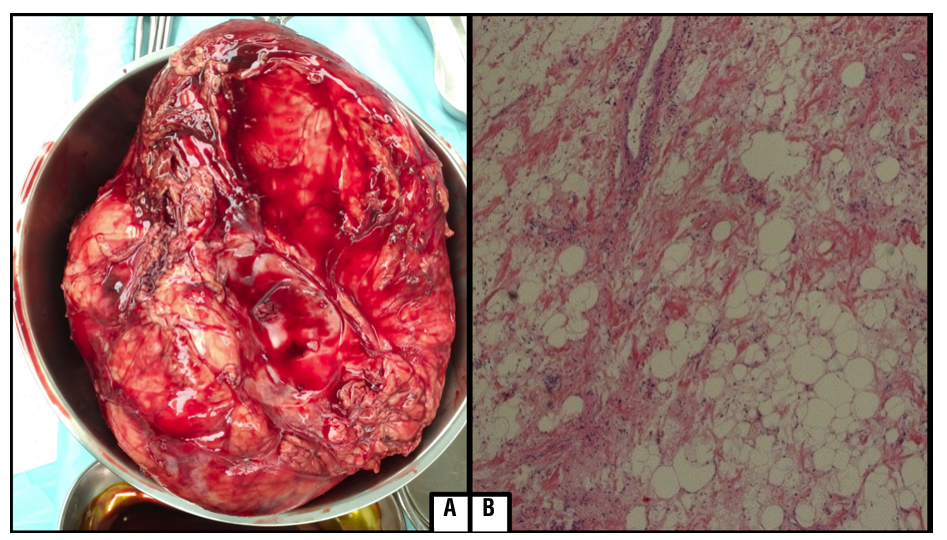
Figure 2 - A) Intraoperative image of the resected specimen. B) Histological examination showed presence of atypical, hyperchromatic stromal cells with a varying number of